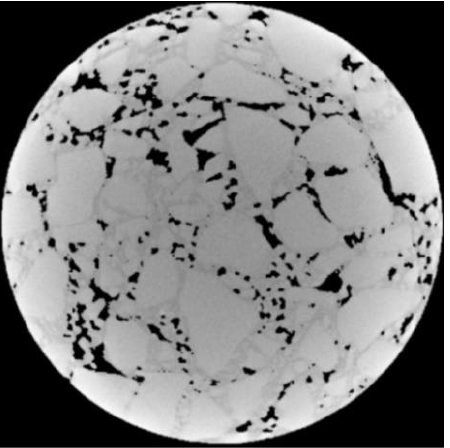
Figure 7. Grayscale image after one annular separation. Next, repeat the operation of annular partition and OTSU threshold segmentation for the grayscale image after one annular separation. The sub-images after multiple separations were assembled, as shown in Figure 8.